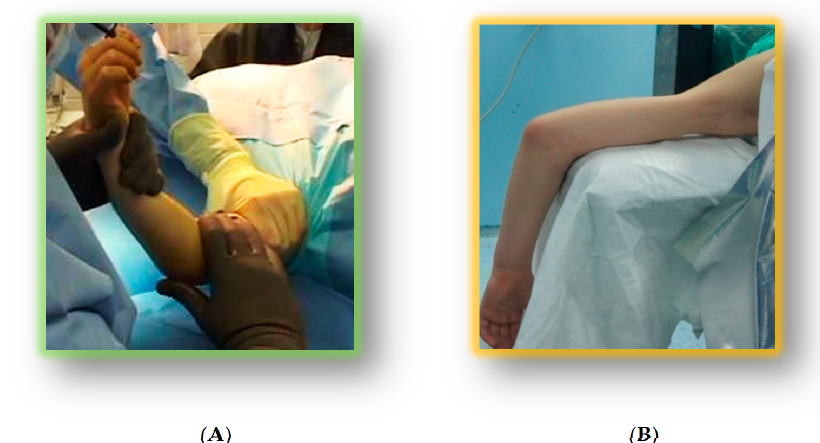
Figure 1. ( A ) Supine positioning; ( B ) Prone positioning.